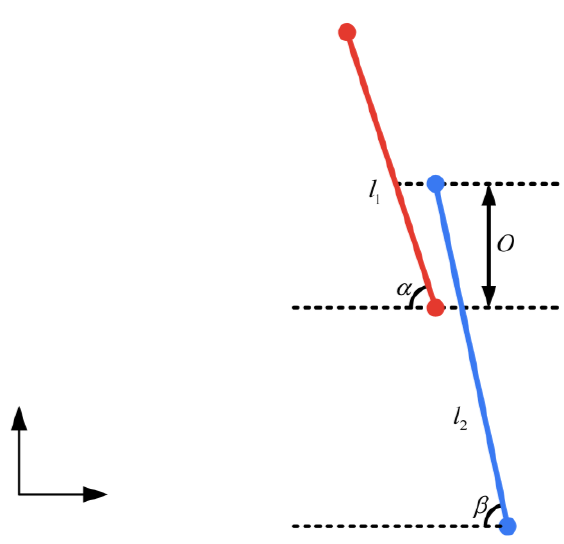
Figure 6. Merging of similar line segments.